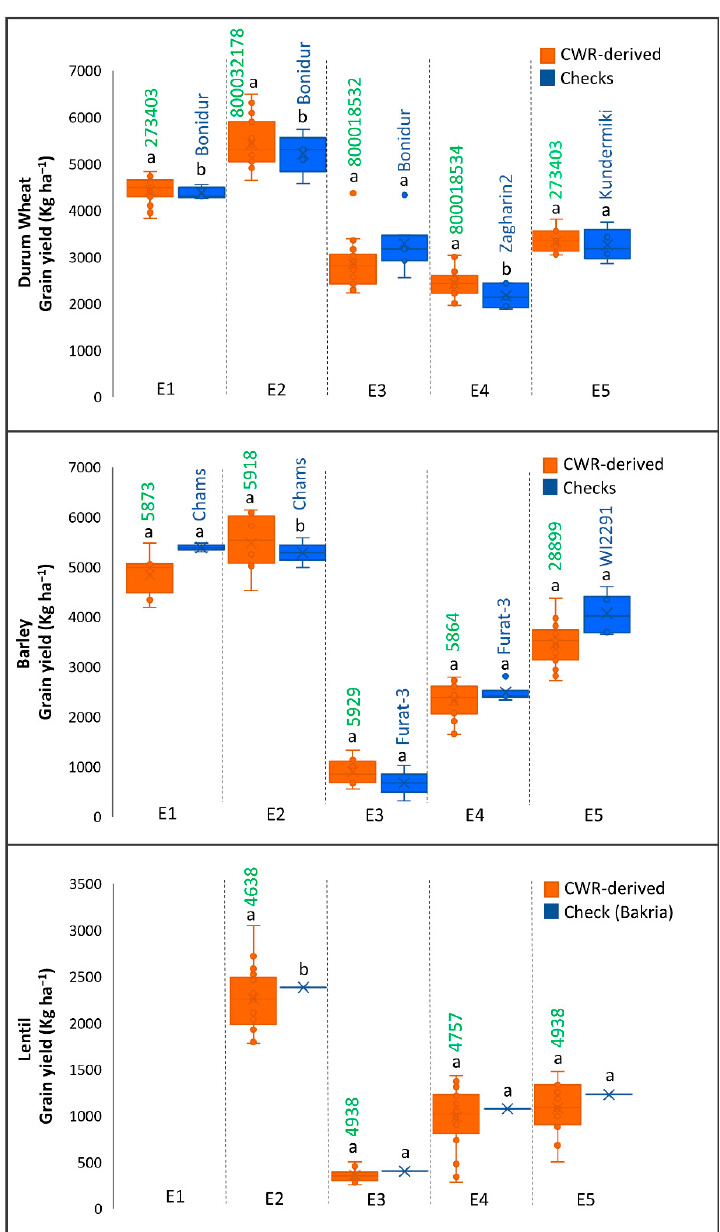
Figure 4. Grain yield (kg ha − 1 ) of the identified clusters of durum wheat, barley, and lentil. The letters “a” and “b” indicate significant differences using LSD at p < 0.05 probability level.